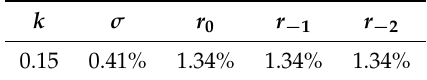
Table 2. Parameters used in the computations of the direct